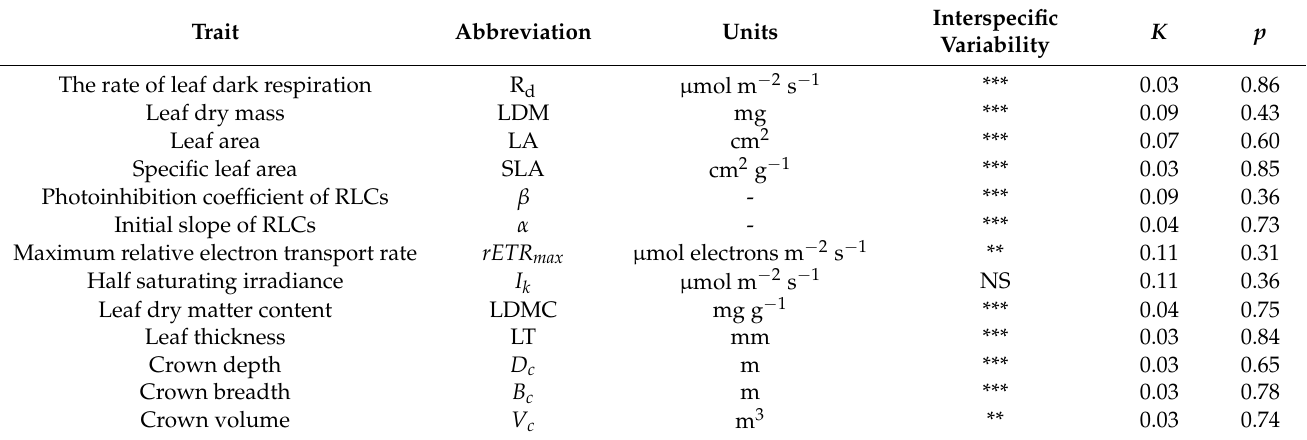
Table 2. The abbreviation, units, the interspecific variability, phylogenetic signal, and the p -values of Blomberg’s K of functional